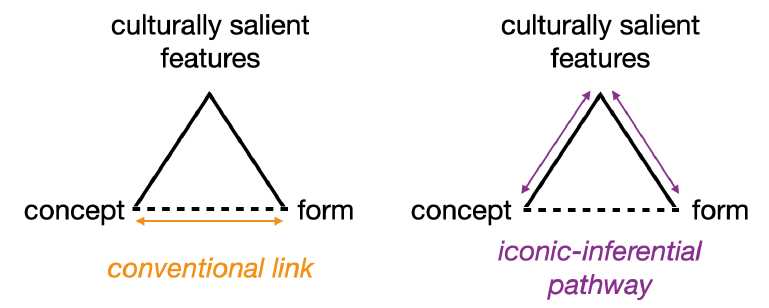
Figure 2. The semiotic triangle used in the current study, consisting of a concept, culturally salient features and a form. The triangle on the left shows the traditional view of the relationship, in which an arbitrary link between the form and concept are made. Depicted in the triangle on the right, we present an alternative route to connecting the form to the concept, through culturally salient features, which we call the iconic–inferential pathway. Figure based on Vogt and Divina (2007), adapted from Ogden and Richards (1925), updated with terminology used in the current